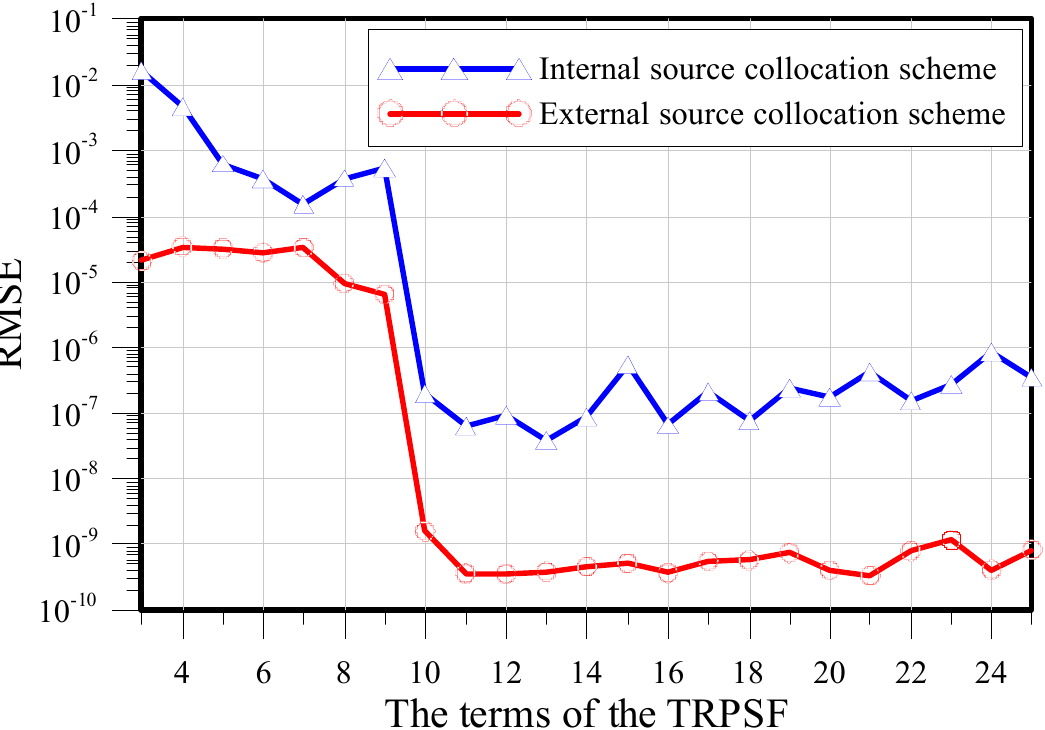
Figure 3. Transient radial polynomial series function (TRPSF) terms versus RMSE.